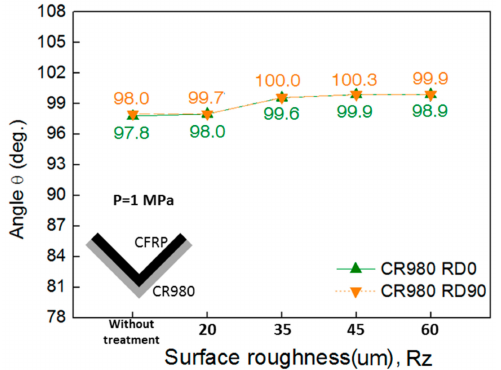
Figure 12. Angle of spring-back of CFRP/CR980 hybrid composites with different levels of surface roughness, conducted by a V-bending test under 1 MPa of the